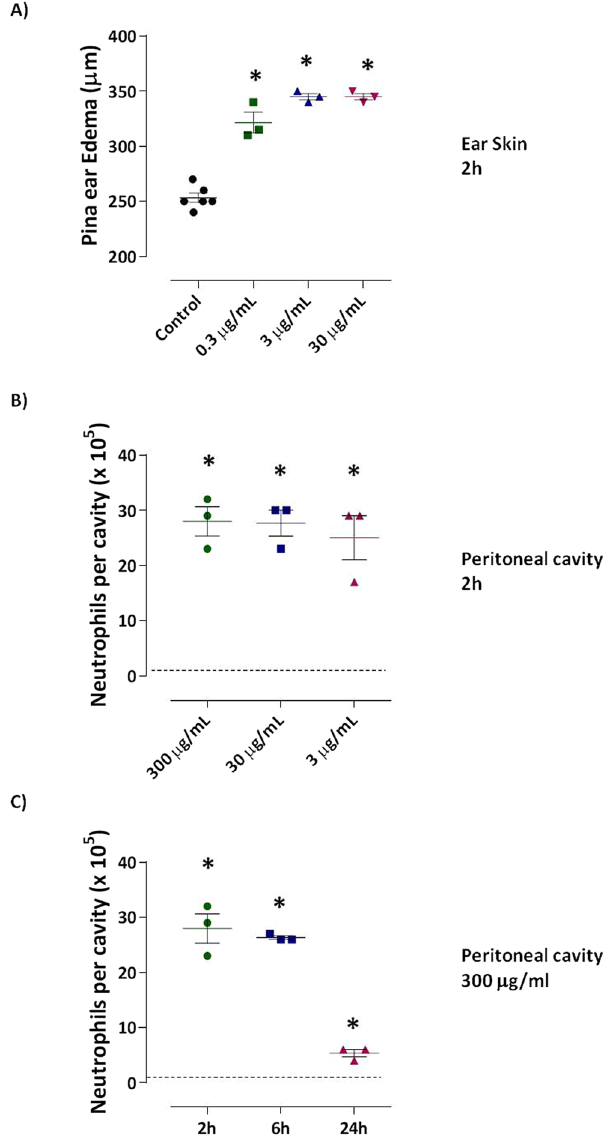
Figure 4. Potamotrygon cf. henlei ray venom induces edema formation in C57BL/6. At 2 h after intradermal injection of ray venom at different concentrations (30, 3, or 0.3 μ g/ml) into the left ear pinna of C57BL/6 mice ( n = 3 per group), ear thickness was measured with a microcaliper. The difference in thickness between the left and the right ear was calculated ( A ). The number of neutrophils was counted in peritoneal cavity exudates collected 2 h after mice were injected with different concentrations of ray venom (3, 30, and 300 μ g/ml - B ) or after injection of 300 μ g/ml at different time points (2, 6 or 24 h - C ). Mice injected with only saline comprised the control-group (dotted line). Results represent mean ± SEM. Pooled results of two independent experiments are shown. * p < 0.05 compared with the